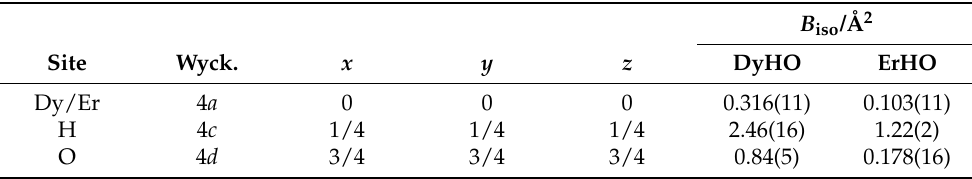
Figure 2. Rietveld refinement of the crystal structures of DyHO based on neutron diffraction data at ambient temperature ( λ = 1.155 Å) and contributions of the included crystal structures (bottom). R wp = 2.89%, GoF = 1.4. Phase information: DyHO F 43 m (59.0(6) wt%, R DyH 1.58(10) Fm 3 m (24.2(4) wt%, a = 5.20261(20) Å), Dy 2 O 3 Ia 3 (16.8(6) wt%, a = 10.6795(7) Å). Red dots: measurement meas , black curve: calculation calc , blue curve: difference meas-calc , purple curve: background. Table 1. The crystal structure parameters of DyHO and ErHO based on neutron diffraction data at ambient temperature 1